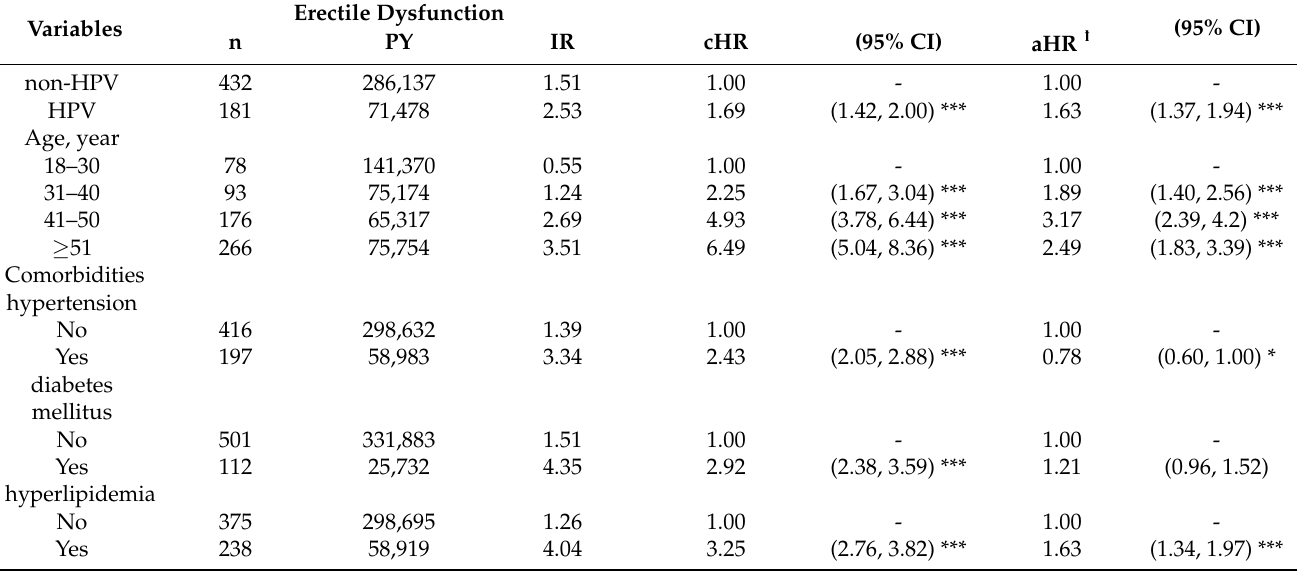
Table 3. The association of explanatory variables and the risk of erectile dysfunction.